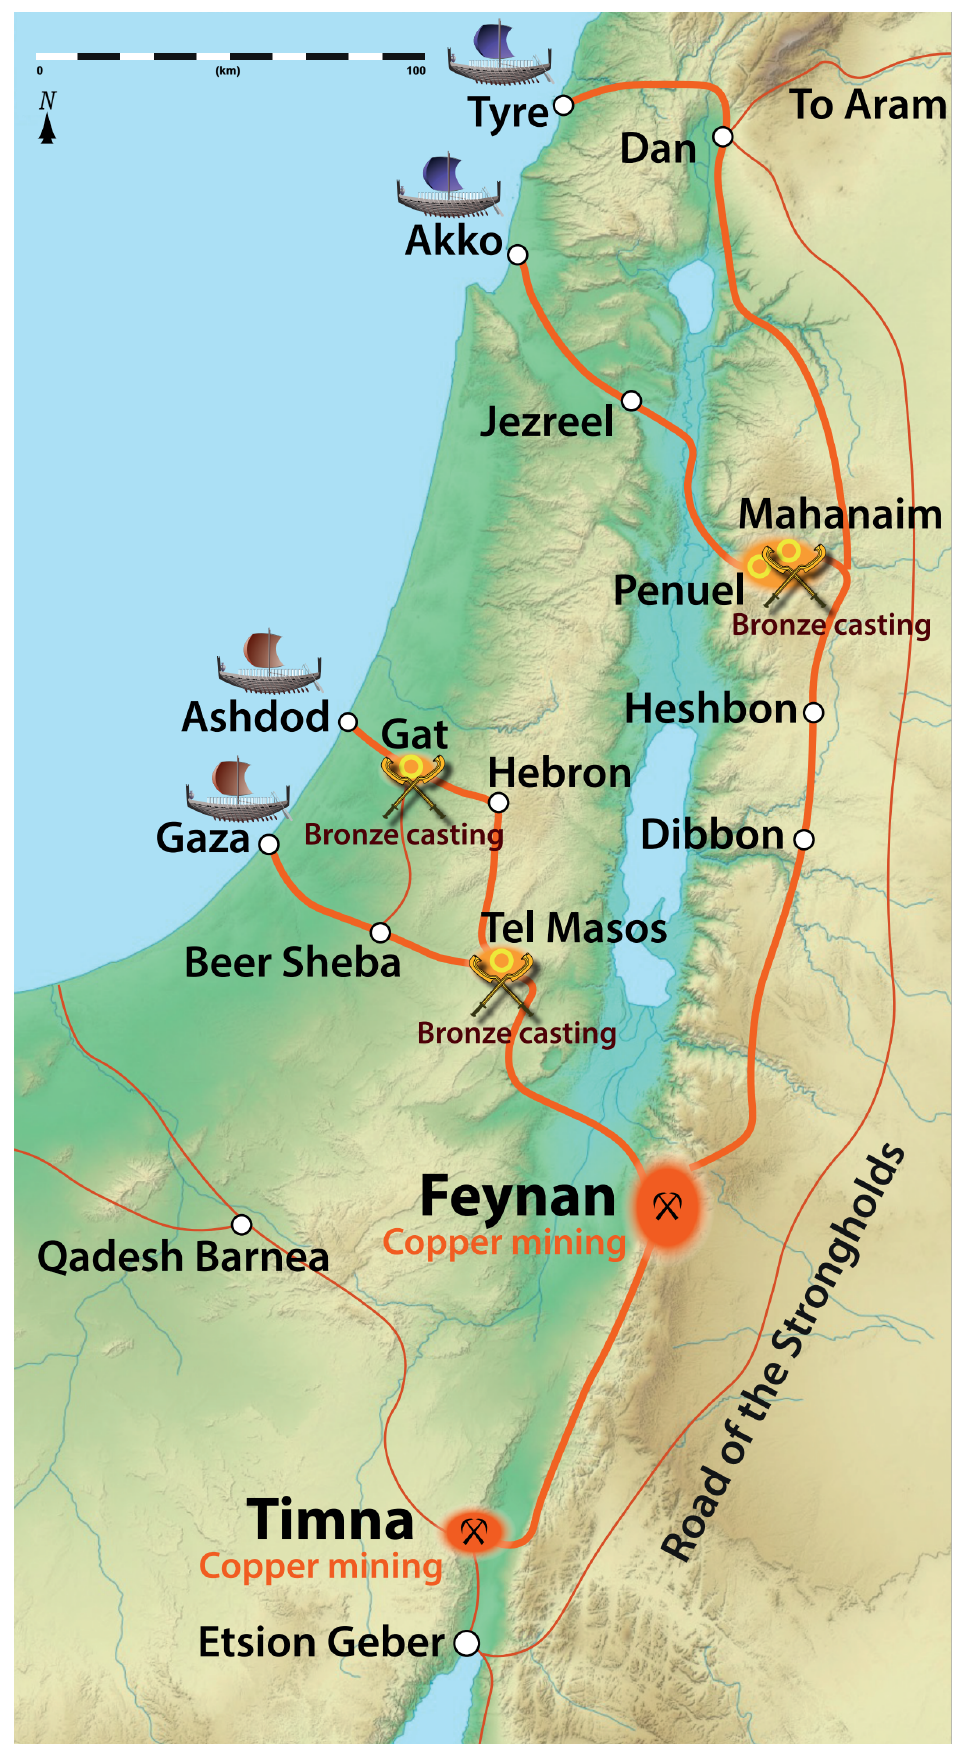
Figure 2 The copper production network in Southern Levant in the Early Iron